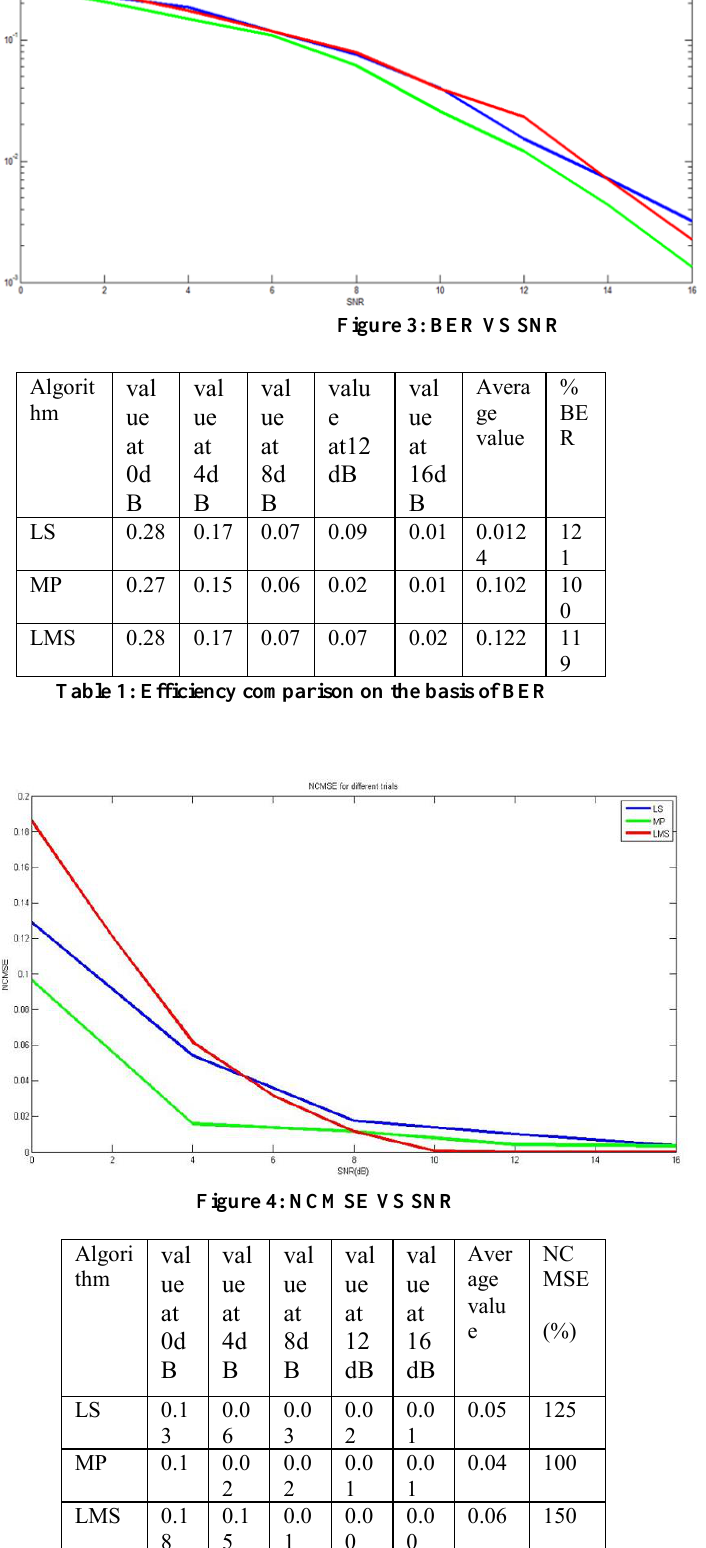
Figure 3: BER VS SNR